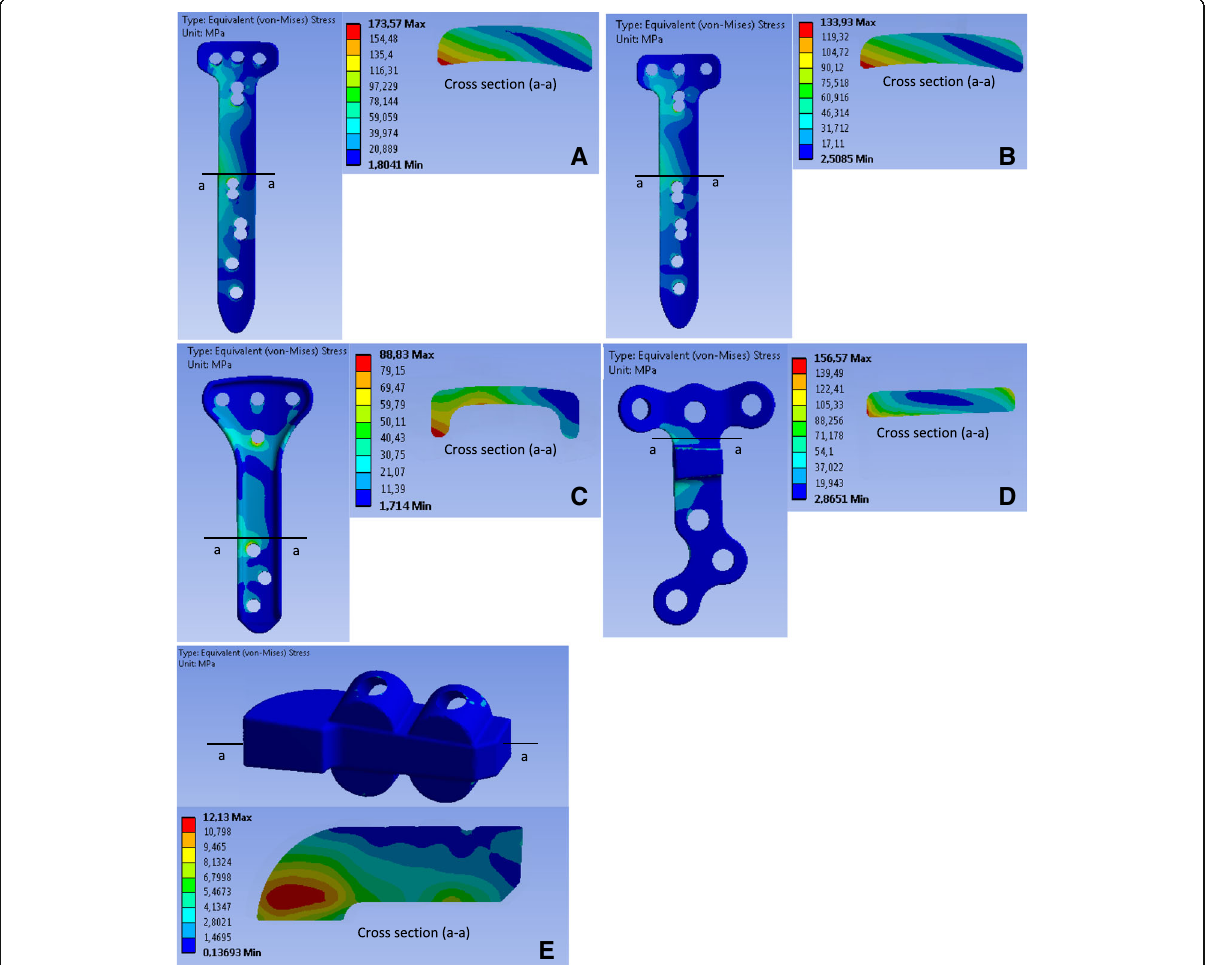
Fig. 5 Equivalent stress (von-Mises) in the implants after the simplified loading of the tibia: The letters a, b, c, d and e indicates the TomoFix sm, the TomoFix std., the PEEKPower, the Contour Lock and the iBalance